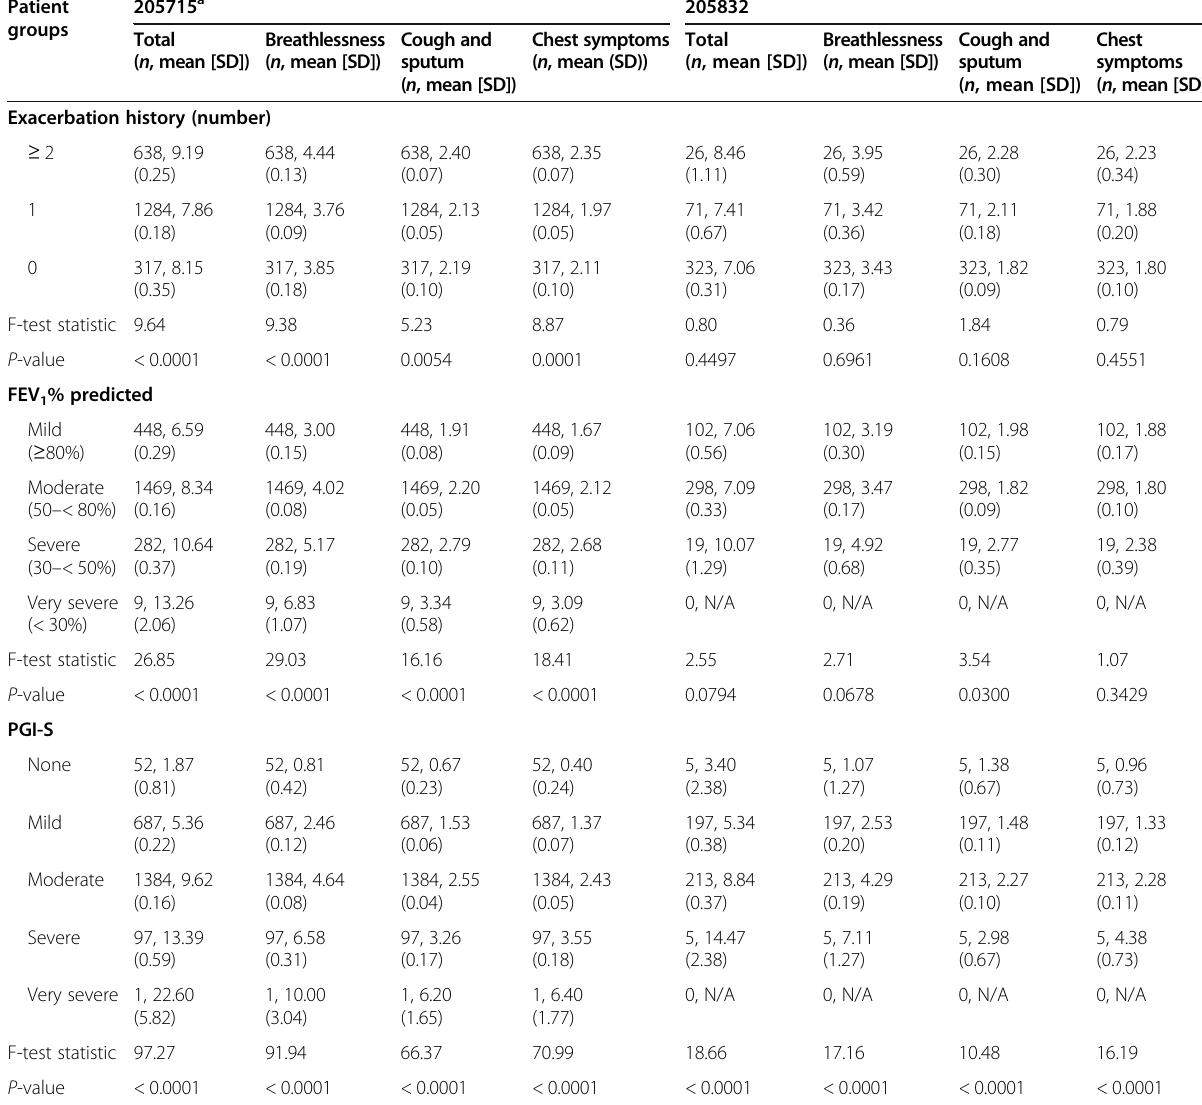
Table 3 Known-groups validity of mean weekly RS-total and subscales at baseline in 205715/205832 Patient